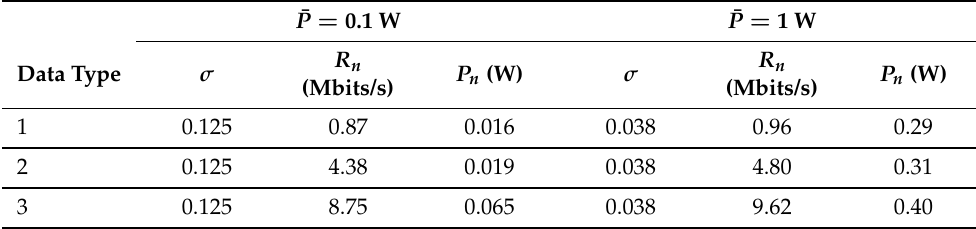
Table 4. Power budget and loss factors are determined using various UAS power